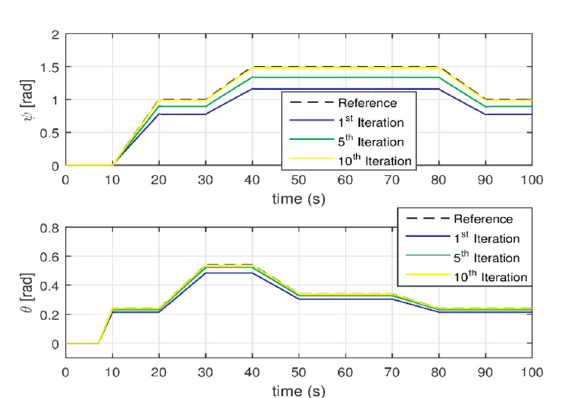
Fig. 11: Reference Tracking at Different Iteration of Hybrid ILC for Reference Trajectory with Sharp Edges